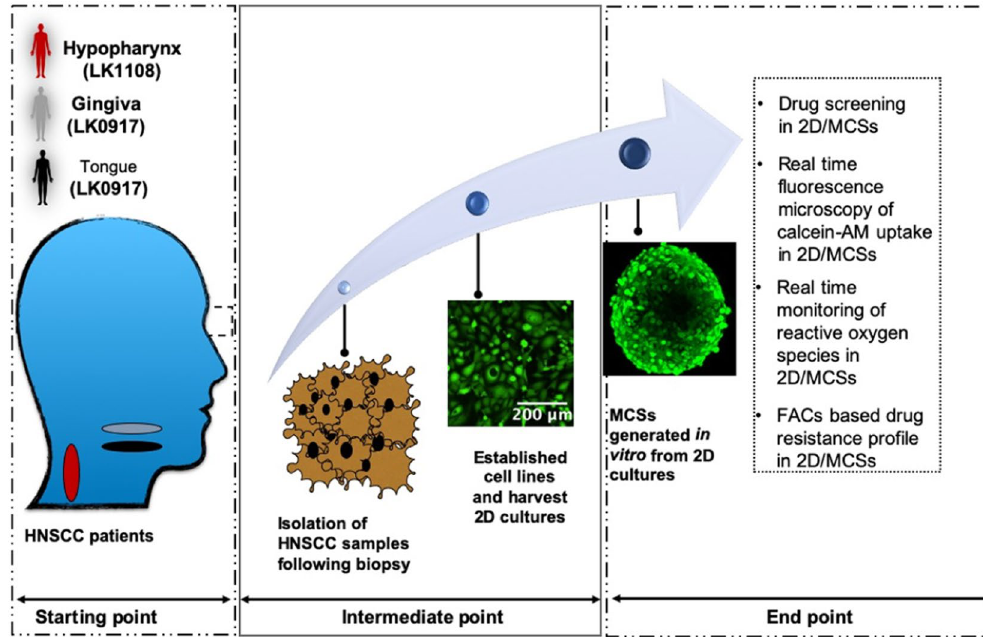
Figure 1. Experimental workflow for MDR screening of cancer cells using MCSs. At the starting point, PTPD tumor biopsies were collected from the gingiva, tongue, and hypopharynx. During the intermediate point, cell lines were established from the pretreated biopsy specimens and in vitro MCSs cultures were generated using these cell lines. In the endpoint, classification of cancer cells as MDR or non-MDR was performed